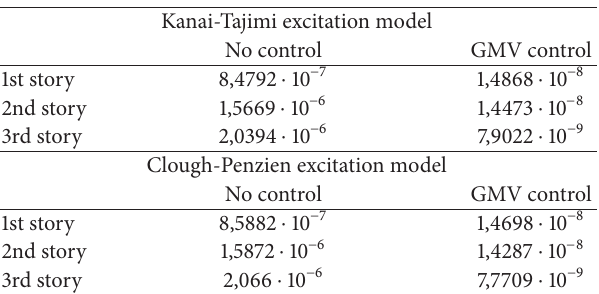
Table 1 gives the output variance for each story. Table 1: Output